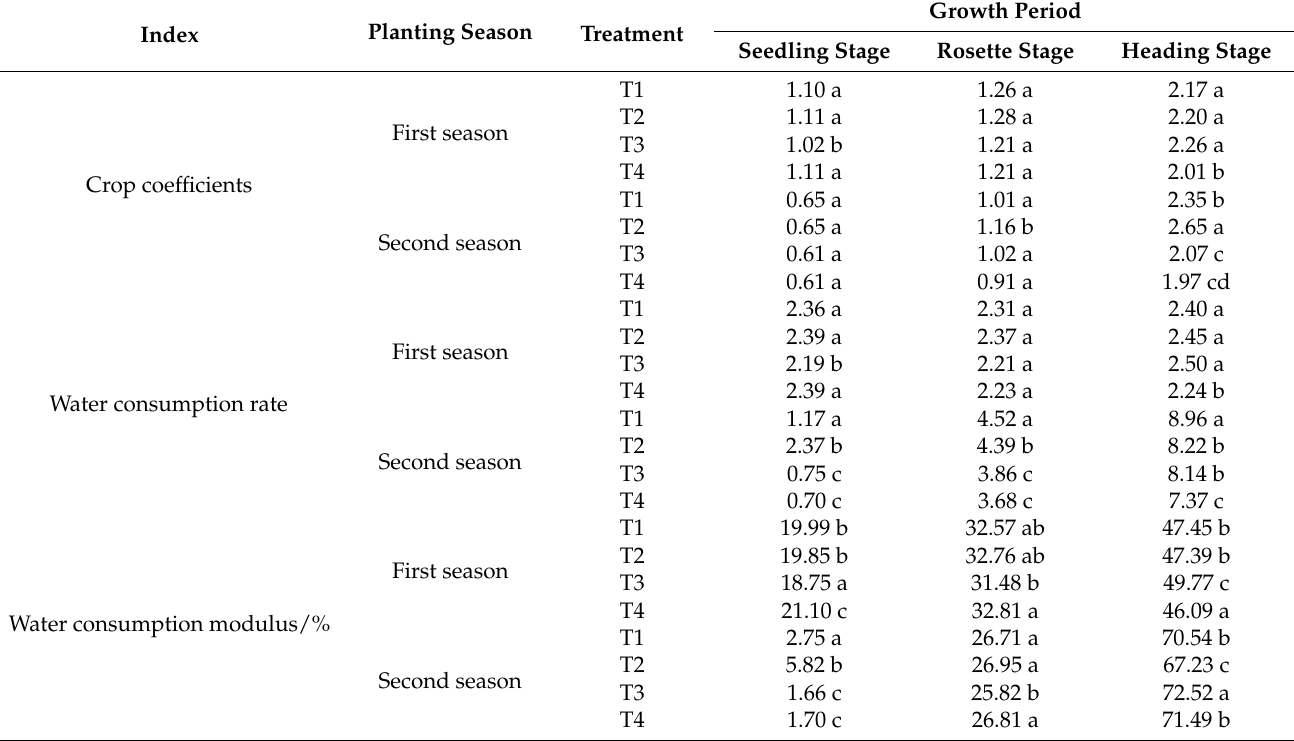
Table 4. K c and water consumption of